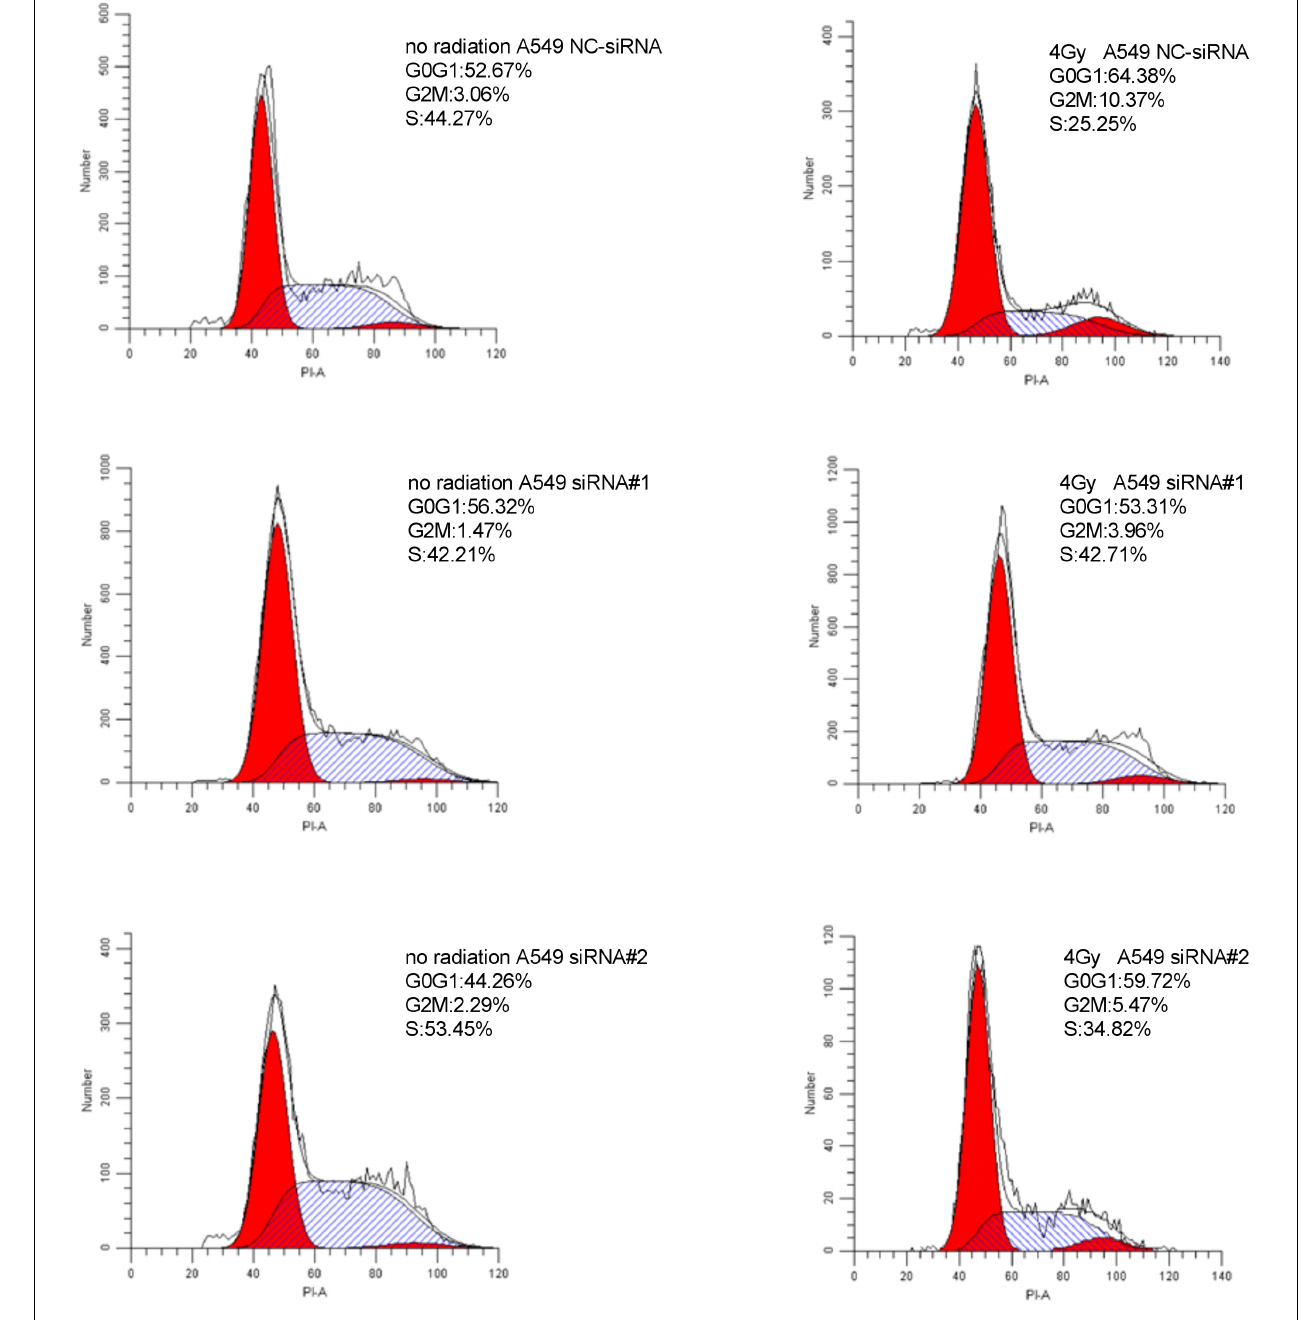
FIGURE 8 | Downregulation of PKMYT1 abolishes irradiation-induced G2/M arrest in A549